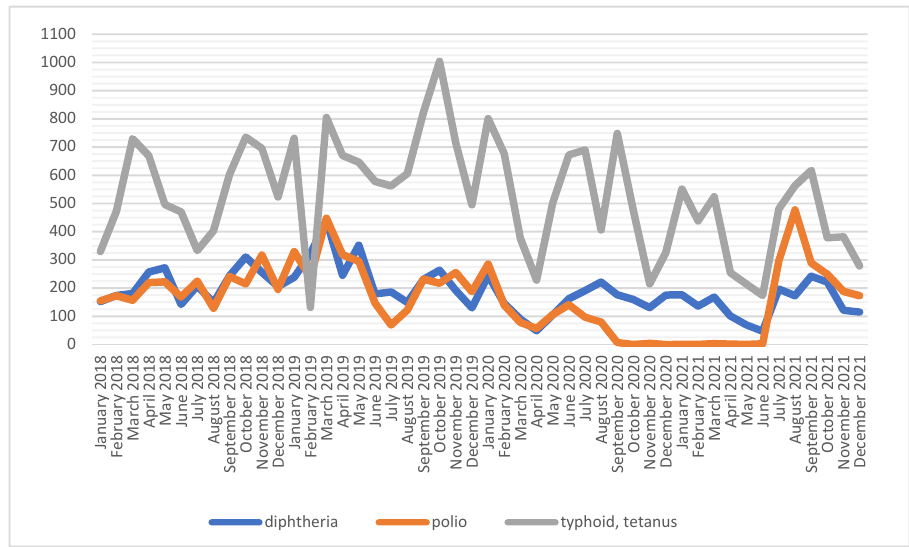
Figure 1. Number of vaccinations against diphtheria, polio, typhoid fever and tetanus among soldiers in 2018–2021.